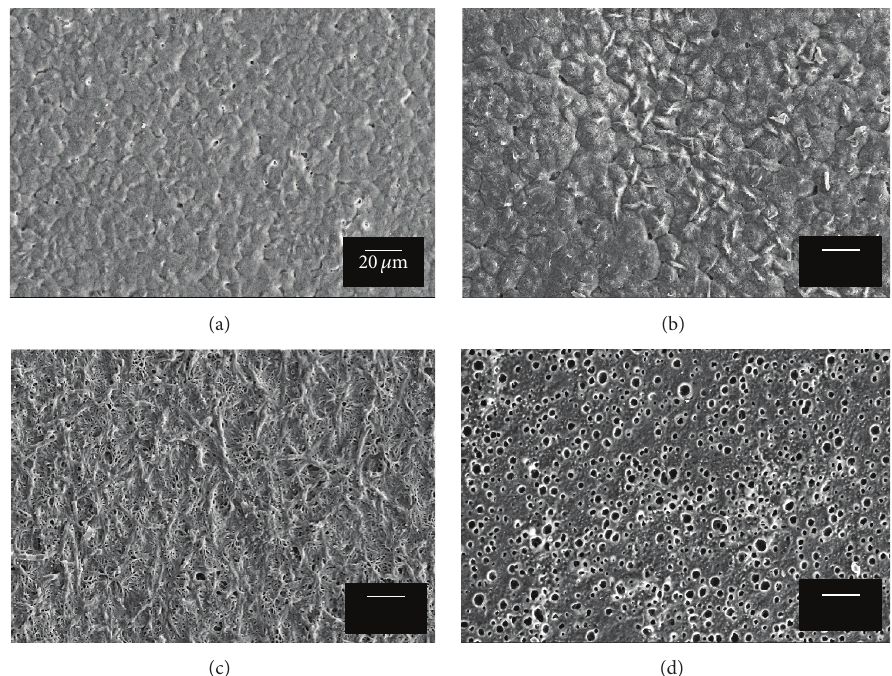
Figure 2: SEM images of surface morphology of (a) P(3HB- co -50mol% 4HB), (b) P(3HB- co -50mol% 4HB)/5wt% collagen, (c) P(3HB- co - 50 mol% 4HB)/10wt% collagen, and (d) P(3HB- co -50mol% 4HB)/15wt% collagen.